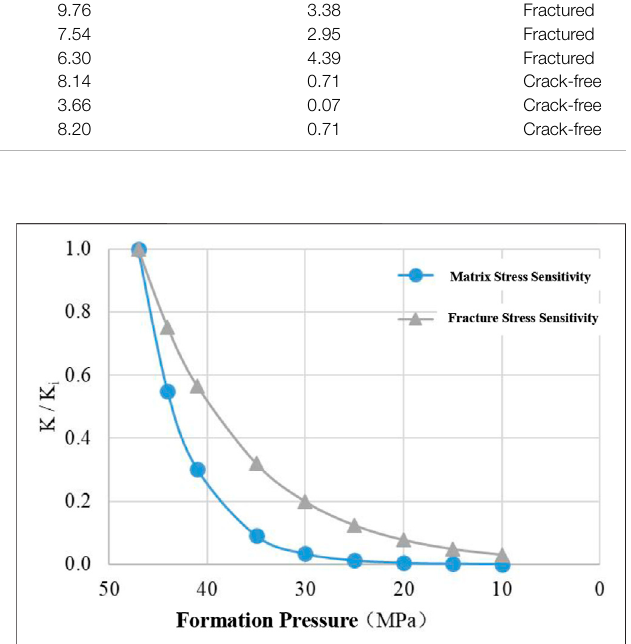
FIGURE 5 | Assignment of stress sensitivity parameters for dual media.